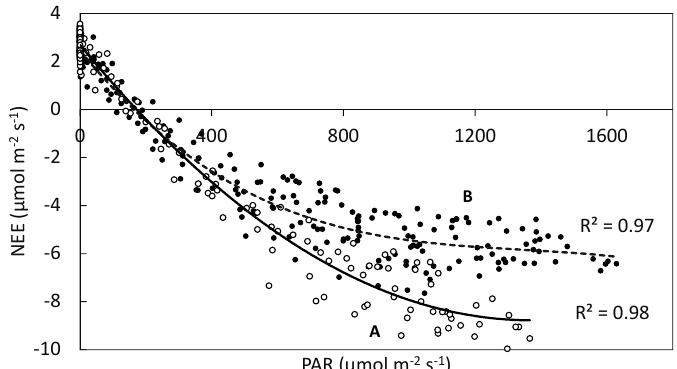
Figure 13. Least square fits of NEE vs. PAR for ( A ) September 2012 to December 2012 (hollow circles); ( B ) Rest of the study period (April–August 2012 and January–March 2013) (filled circles). Apparent quantum yield ( α ), described as the number of molecules of CO 2 fixation per unit of photons irradiated on the leaf, plays an important role in understanding the tree photosynthetic response, and estimating “ α ” would provide useful information for ecosystem models over larger areas [50]. Apparent quantum yield is often calculated by fitting a rectangular hyperbolic function between NEE and PAR, where there is a near ‐ linear response during low light conditions and saturation to maximum productivity at higher light conditions. The ecosystem photosynthetic parameters in the present study are estimated using the Michaelis ‐ Menten equation as given below and as described by Ruimy et al. [51].